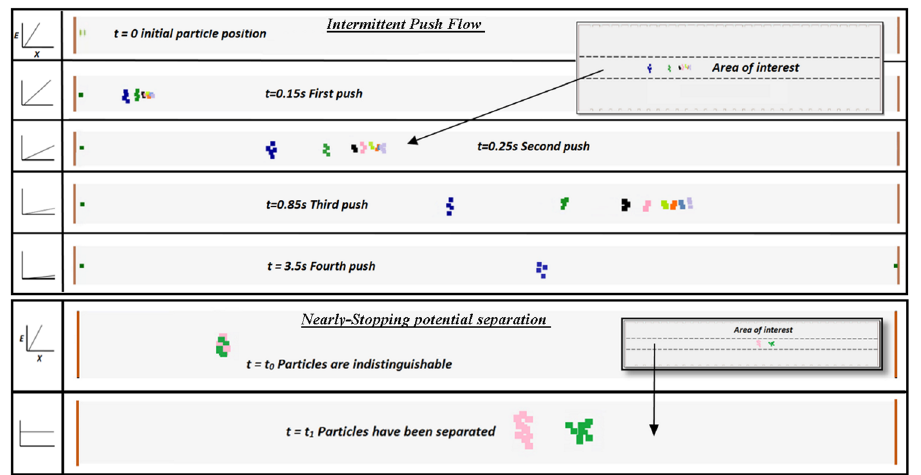
Figure 6. ( A,Top ) SIMION simulations of particles ranging from 20 to 120 nm in diameters using intermittent push flow. Simulations are shown at the time when each of the subsequent pushes is taken by lowering the slope of the field. All particles are easily separated in time and space and collected at the end of the drift tube. ( B,Bottom ) Simulation of Nearly stopping potential separation method depicted in Fig. 2b for two particle sizes of 55.89 and 55.93 nm where both particles have been